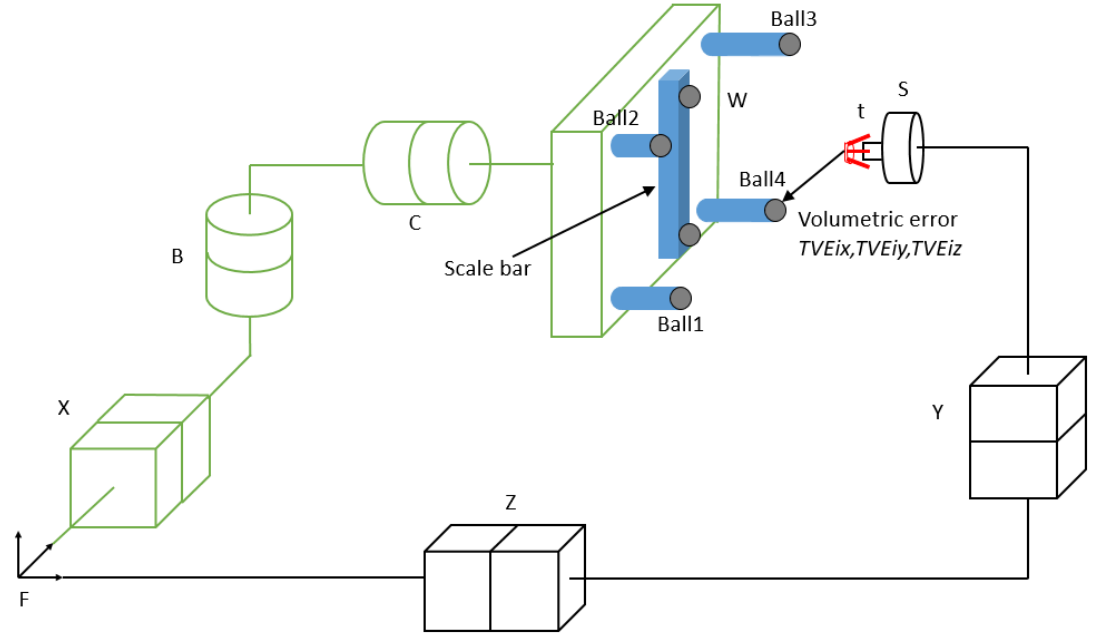
Figure 6. Machine schematic with thermally induced volumetric errors. The TVEs have three positioning error components as described in Equation (2). These error components may change with activities of the B- and C-axis, positions, and indexations.